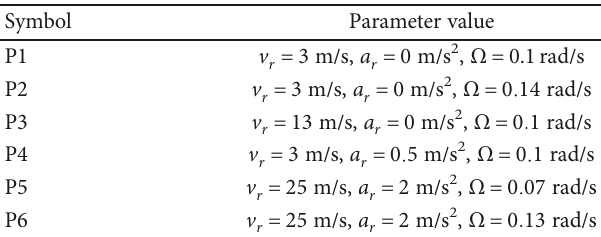
Table 2: The motion parameters of the maneuvering target in di ff erent